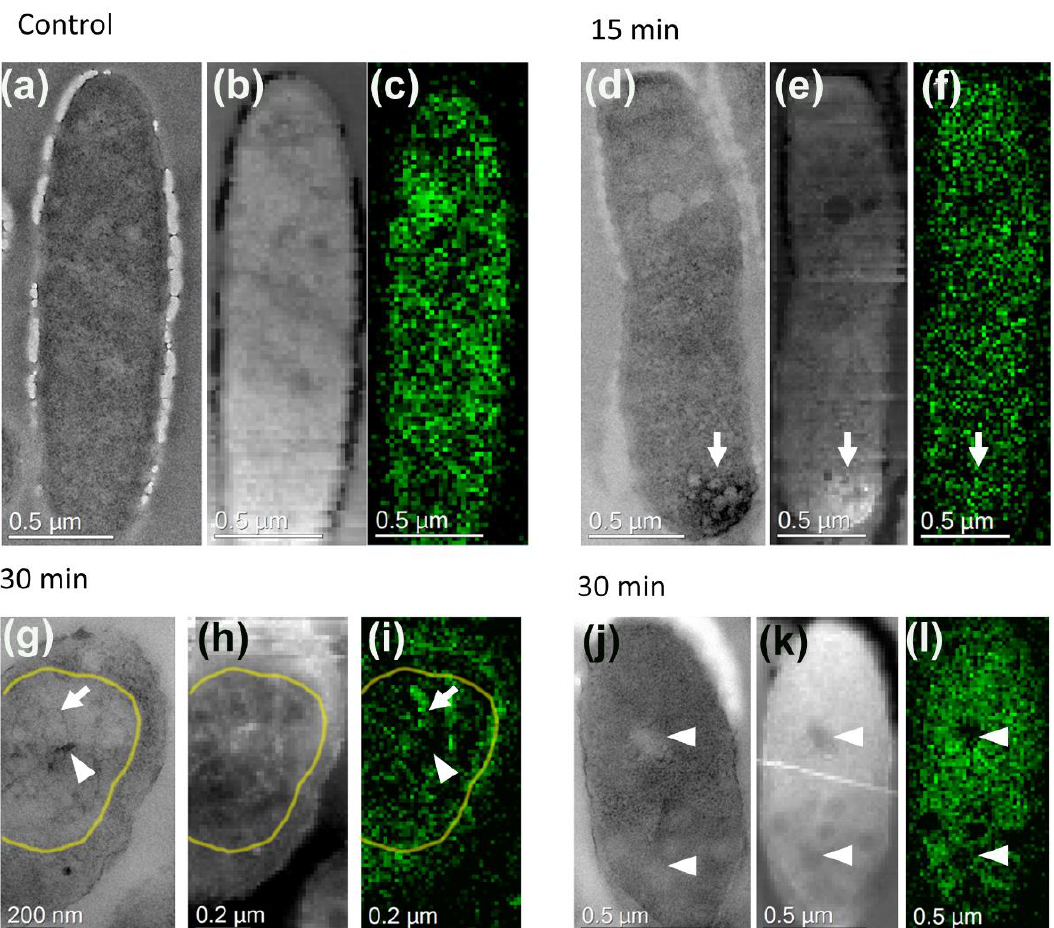
Figure 2. Phage and bacterial DNA distribution in control and infected P. aeruginosa cells. TEM image ( a , d , g , j ); HAADF image ( b , e , h , k ), and electron energy loss spectroscopy (EELS) Phosphorus distribution maps through the pseudo-nucleus ( c , f , i , l ). Phosphorous (P) signal was mapped after background subtraction and multiple scattering correction with Fourier-ratio deconvolution. Arrows are pointing to the DNA-containing structures; arrowheads—to the areas, which do not contain the P signal; yellow outlines in ( g , h , i ) roughly mark the pseudo-nucleus border.